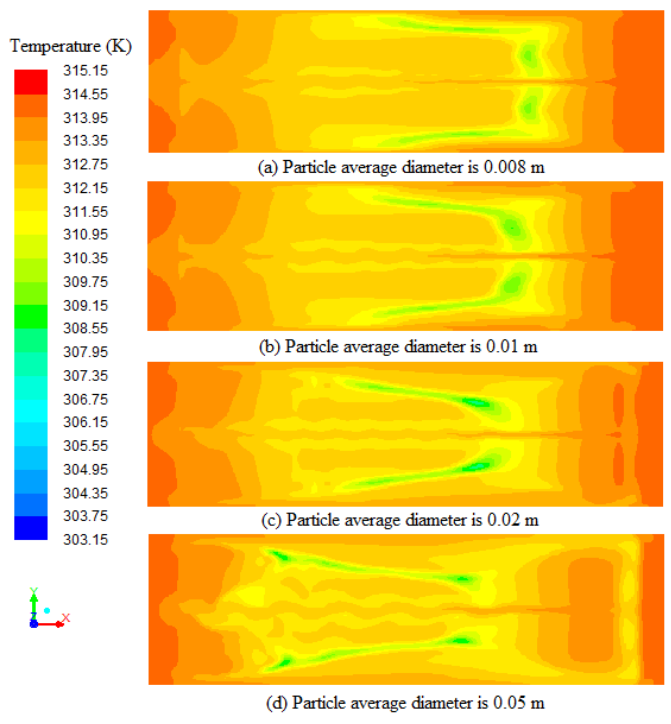
Figure 13. Temperature profiles on the cross-section (0.8 m from ground) at 38,400 s with different particles average diameters (a = 0.008 m, b = 0.01 m, c = 0.02 m, and d = 0.05 m) of porous zones.